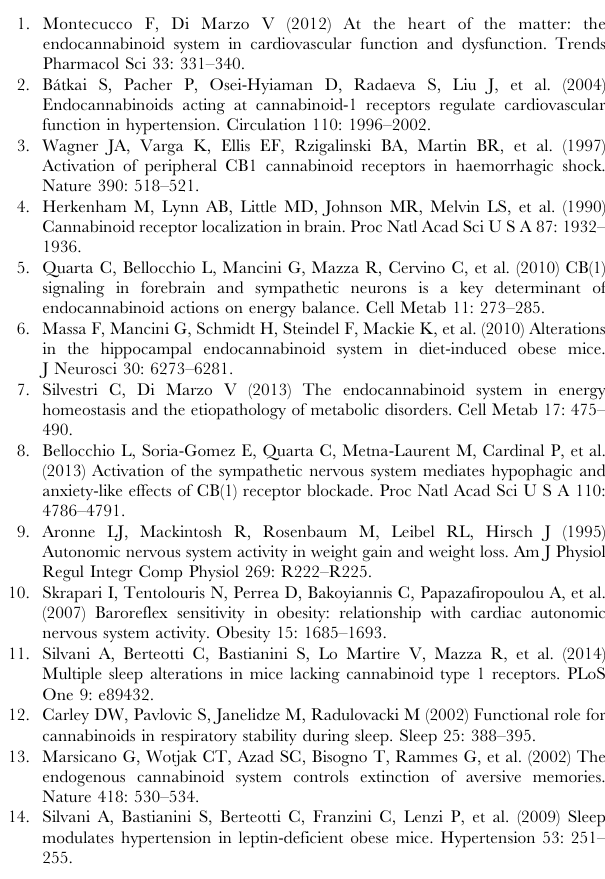
Table S1 Daily profiles of mean arterial pressure and heart rate: ANOVA results. (DOC) Table S2 Cardiovascular changes as a function of the wake-sleep state: ANOVA results. Table S3 Cross-correlation analysis of cardiovascular coupling: ANOVA results. (DOC) Table S4 Coherent averaging of spontaneous surges of arterial pressure: ANOVA results. Table S5 Sleep-related changes in tidal volume, respi- ratory period, and minute ventilation: ANOVA